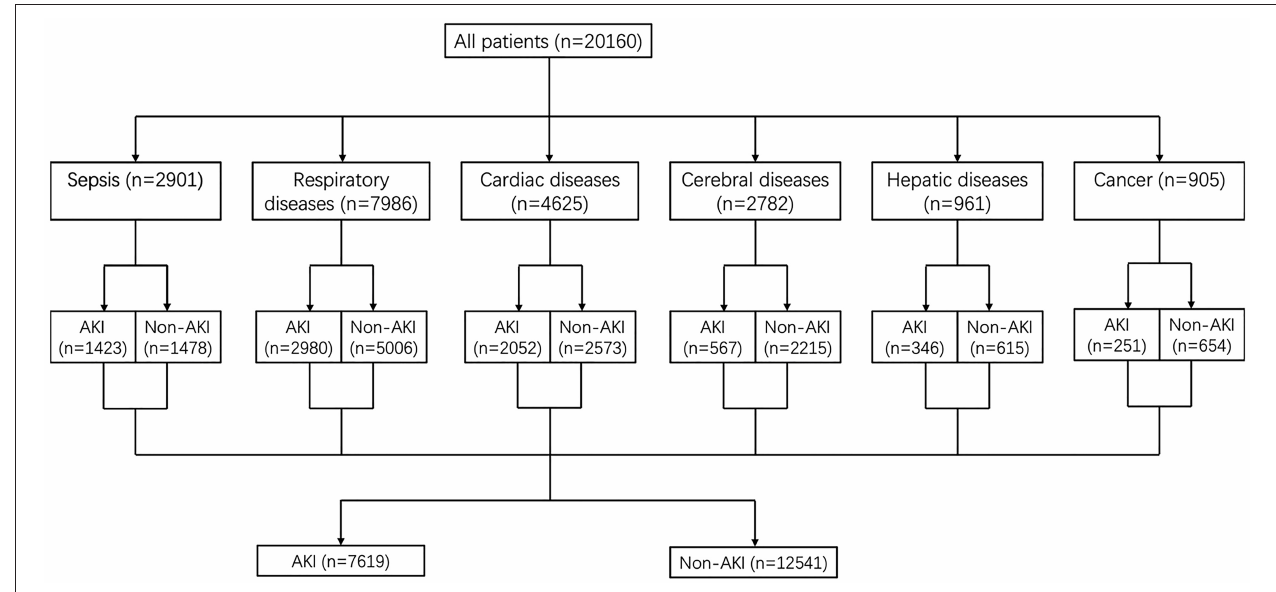
FIGURE 1 | Study population.